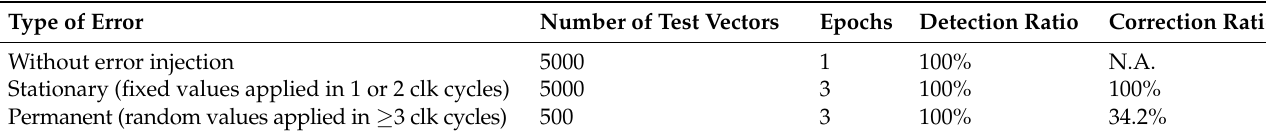
Table 6. Test results for fault